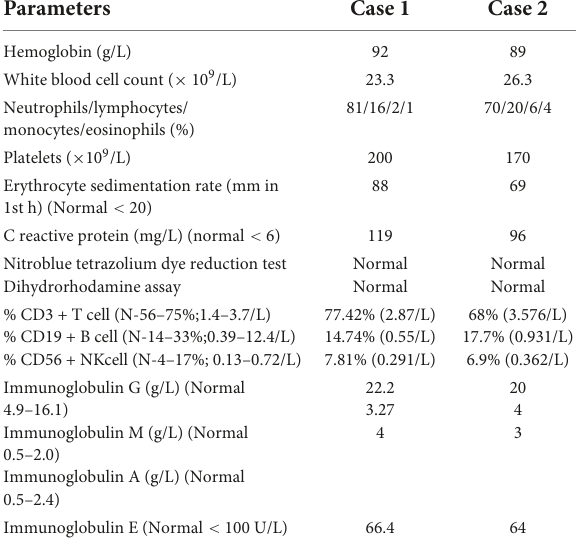
TABLE 1 Laboratory